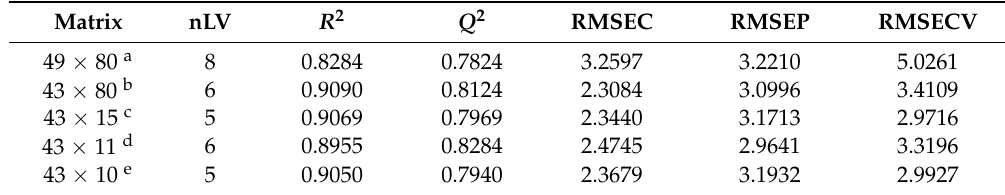
Table 1. Comparison of partial least squares regression models before and after variable selection. Matrix nLV